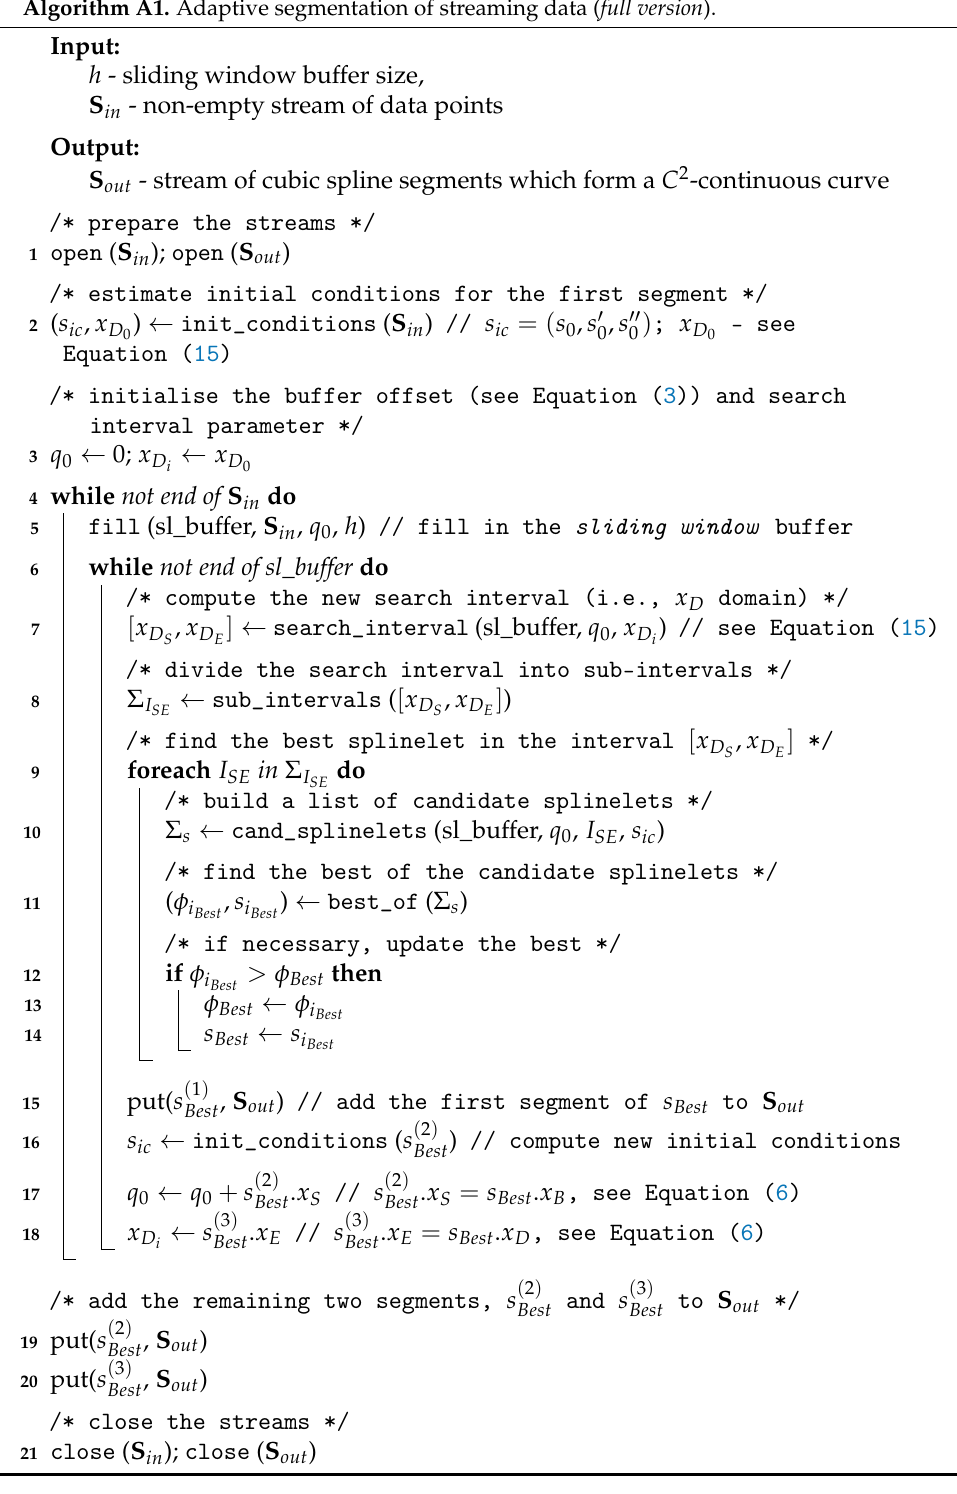
Algorithm A1. Adaptive segmentation of streaming data ( full version